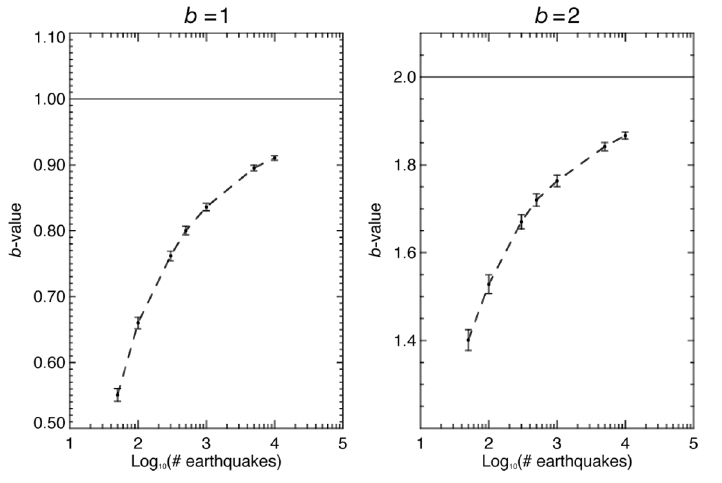
Fig. 4. Average of b t (dashed line) calculated through binned LS technique in 1000 synthetic catalogs, as a func- tion of the catalog size, for the cases b = 1 ( left ) and b = 2 ( right ). At each average is attached the 95% confidence interval. The solid line represents the true b -value.